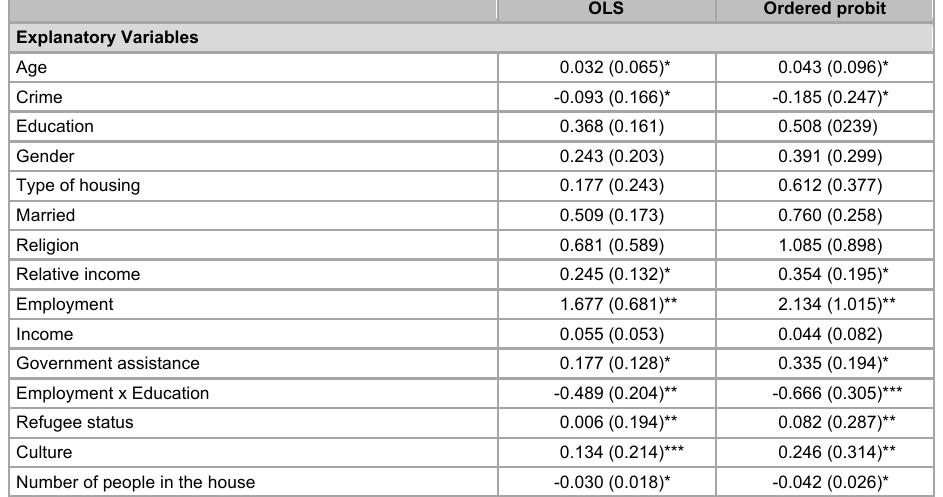
Results on the determinants of expected well-being OLS Ordered